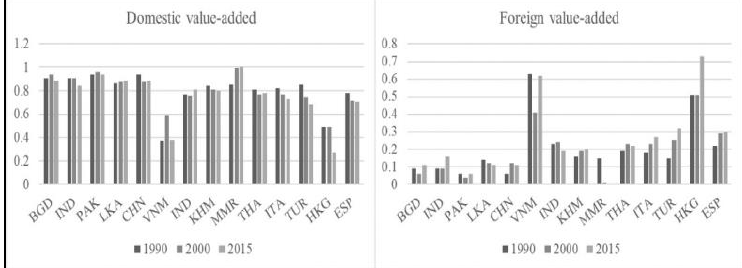
Figure 4: Domestic and foreign value-added shares of total final export of Textile and Apparel sector; Source: Authors